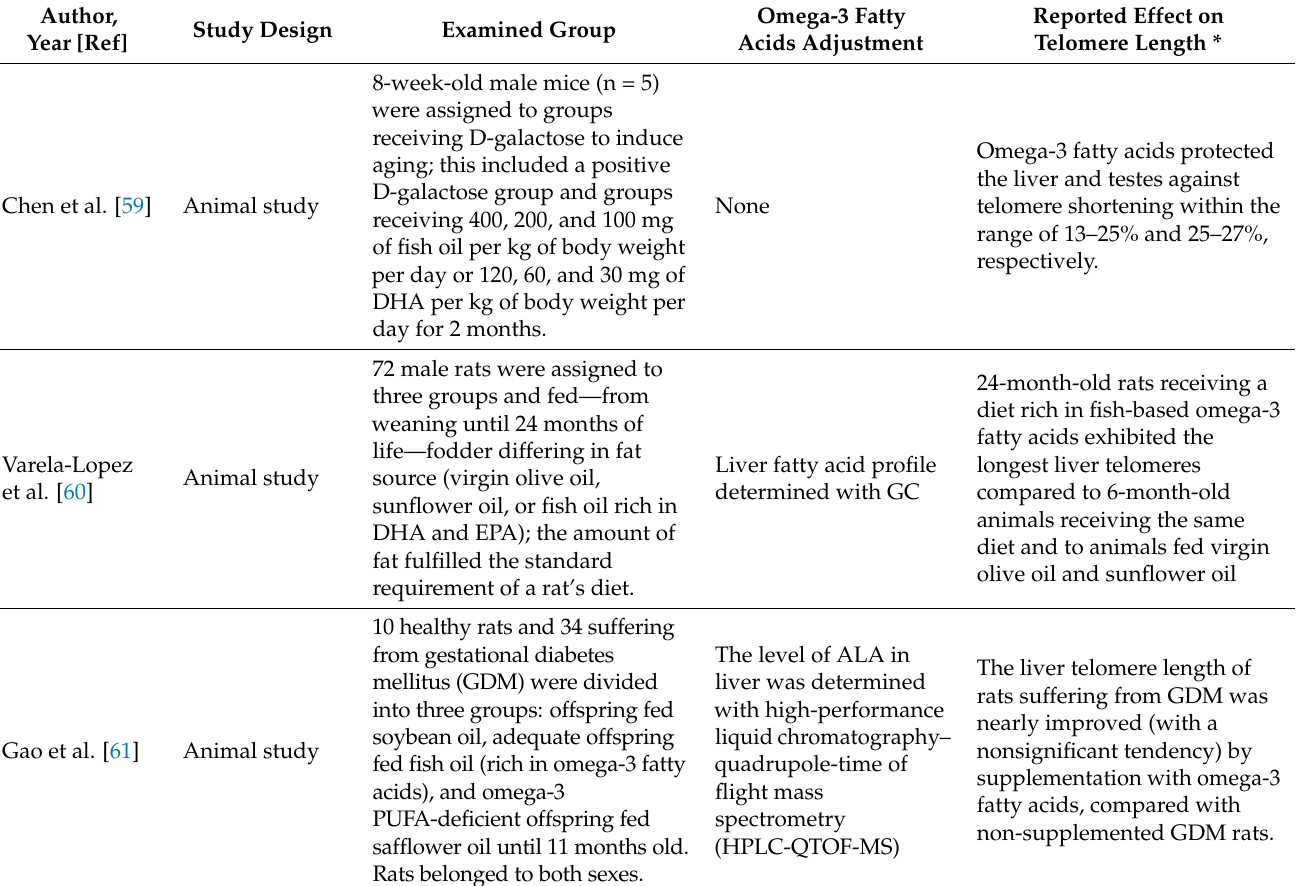
Table 2. Studies documenting a link between omega-3 fatty acid intake and telomere length in